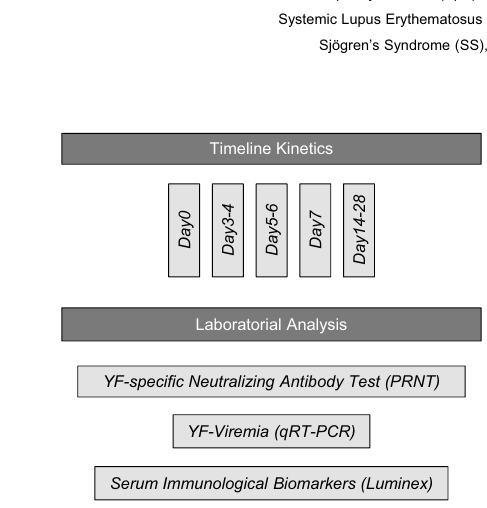
Figure 7. Study Design and Methods. This is a prospective non-interventional observational study carried out between March, 2017 and July, 2017 in Vitória, Espírito Santo, Brazil. A total of 140 patients with Autoimmune Disease patients (AID) including: Rheumatoid Arthritis (RA, n = 38), Spondyloarthritis (SpA, n = 51), Systemic Lupus Erythematosus (SLE, n = 21) and Sjögren’s Syndrome (SS, n = 30). A group Healthy Controls